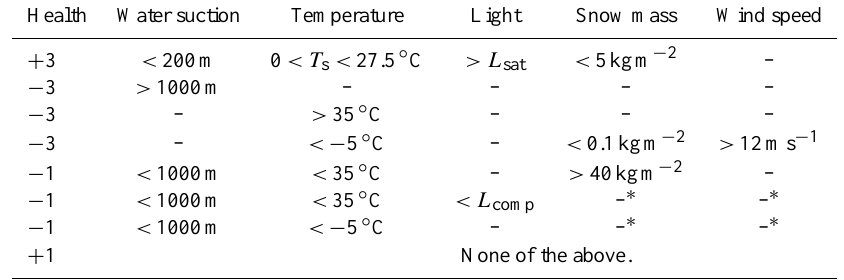
Table 1. Conditions for moss growth and dieback. For light saturation and compensation curves ( L sat and L comp ) see Eqs. (2) and (3). Health Water suction